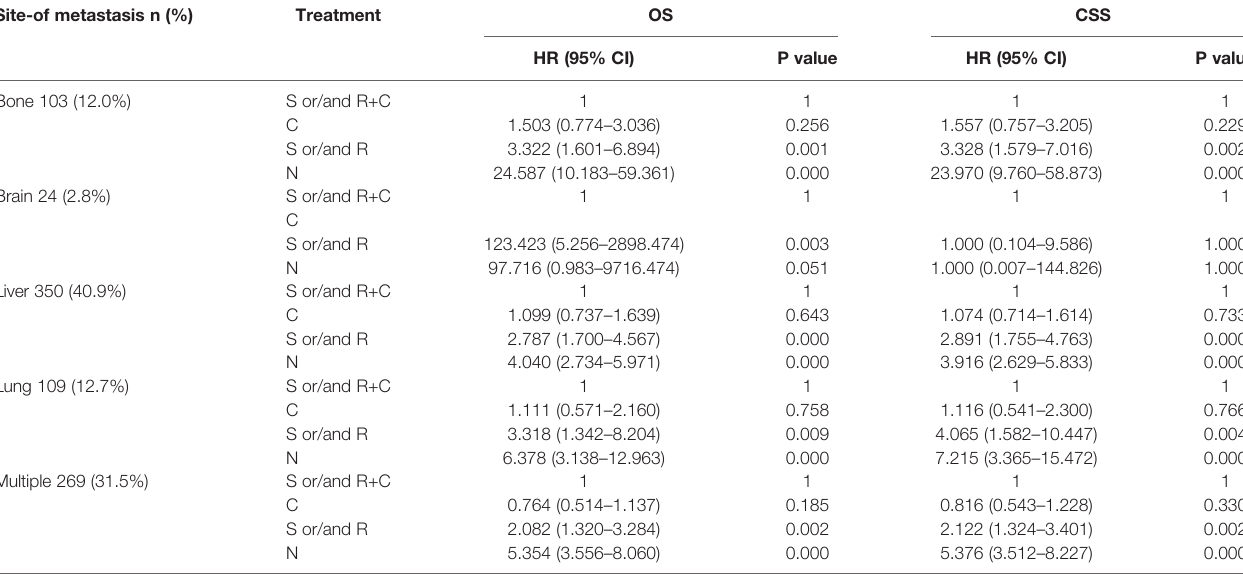
TABLE 3 | Results of Multivariate analysis using the COX proportional hazards model of the different populations. Site-of metastasis n (%) Treatment